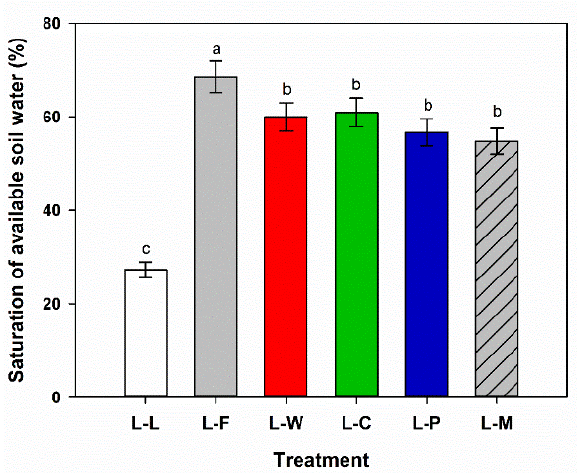
Figure 5. Volumetric soil water content in the 0–300 cm soil depths after lucerne-to-crop conversion in October 2018. Horizontal bars denote Fisher’s protected least significant difference at p ≤ 0.05. Treatment abbreviations are defined in Table 1.